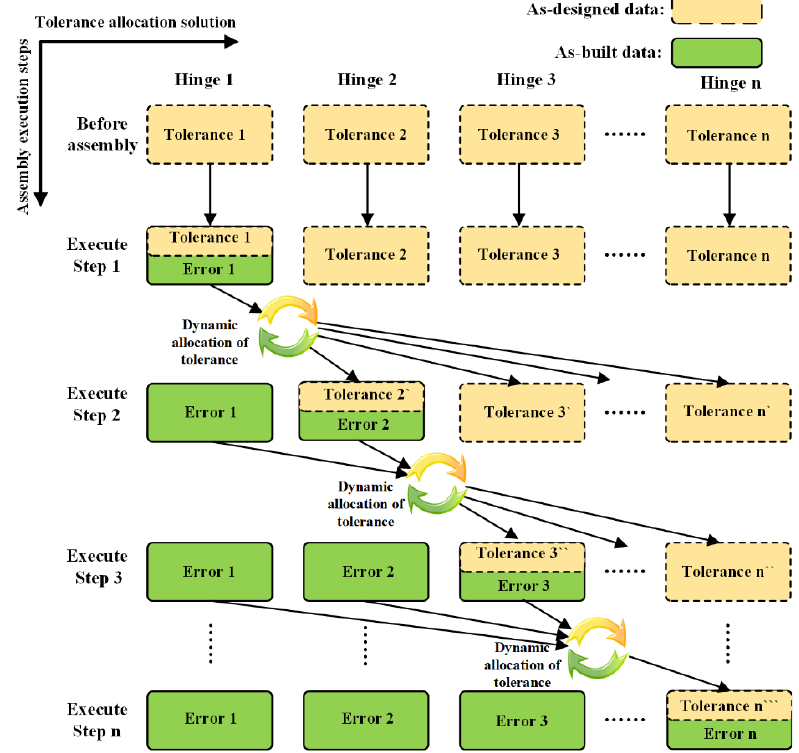
Figure 11. Dynamic allocation of tolerance among assembly processes.